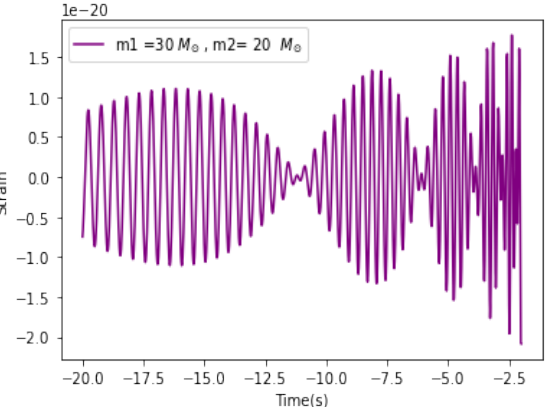
Figure 1. A diagram showing the beat pattern of a binary inspiral signal. Masses of the components are m 1 = 30 M (cid:12) and m 2 = 20 M (cid:12) , the source is located at z s = 2, the lens at z l = 1 is assumed to be a point mass of M l = 10 6 M (cid:12) . Time delay has been chosen as ∆ t = 2.1 s , thus fixing the β